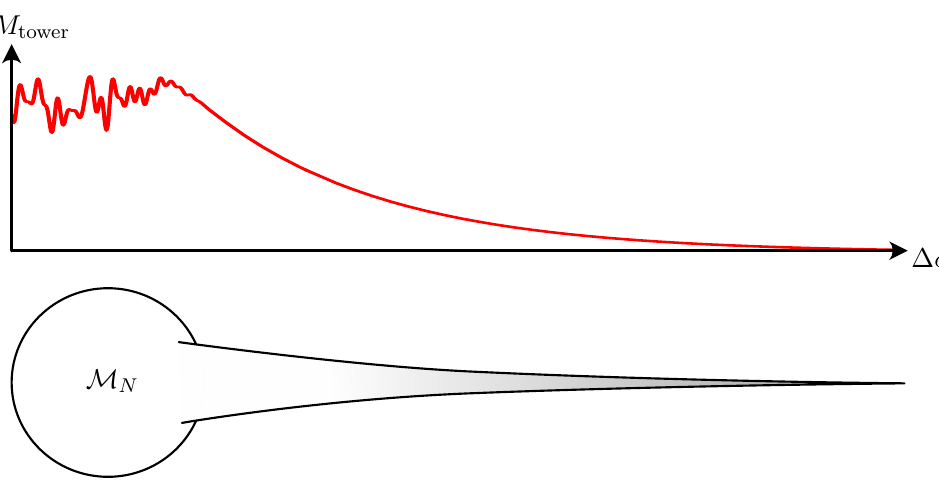
Figure 1 . Sketch of the behavior of the DC tower mass scale over moduli space. In the bulk M N of the moduli space the distance conjecture does not impose any constraint on M the throat region we approach M exp( − α ∆ φ ) tower ∼